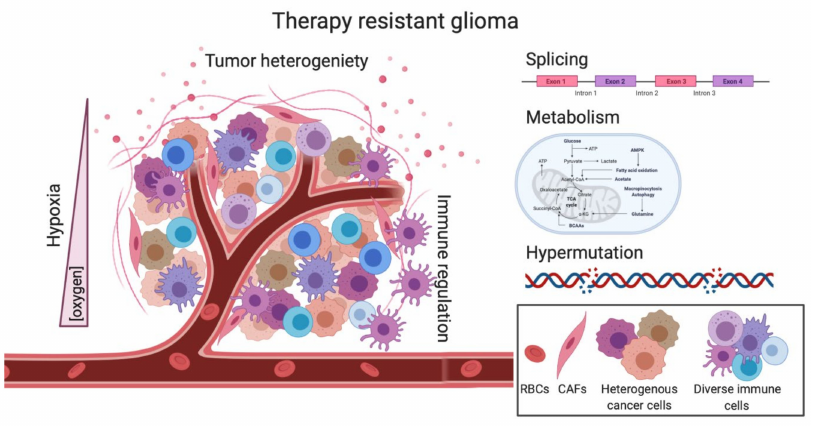
Figure 3. Complex pathways underlie the therapeutic resistance of GBM. The decrease of oxygen within in the tumor can facilitate hypoxia-induced signaling which can render cells less sensitive to treatment. Tumor heterogeneity can complicate therapeutic response as not all clones are targeted equally by standard treatments. Immune regulation is severely dampened in GBM, creating a “cold” TME. Splicing changes via RBPs or splicing factors can affect isoform outcome leading to dysregulated AS. Metabolic changes induced by TMZ or RT are able to change metabolism in both the tumor cells as well as the TME, creating a therapeutic-resistant microenvironment. TMZ-induced hypermutation can create a hypermutator state in which patient outcome is correlated with a worse overall survival, as compared to other cancers. Overall, many pathways play a role in GBM therapeutic resistance, and all should be investigated for better second-line treatments. RBPs, RNA binding proteins; AS, Alternative splicing; RBCs, red blood cells, CAFs, cancer-associated